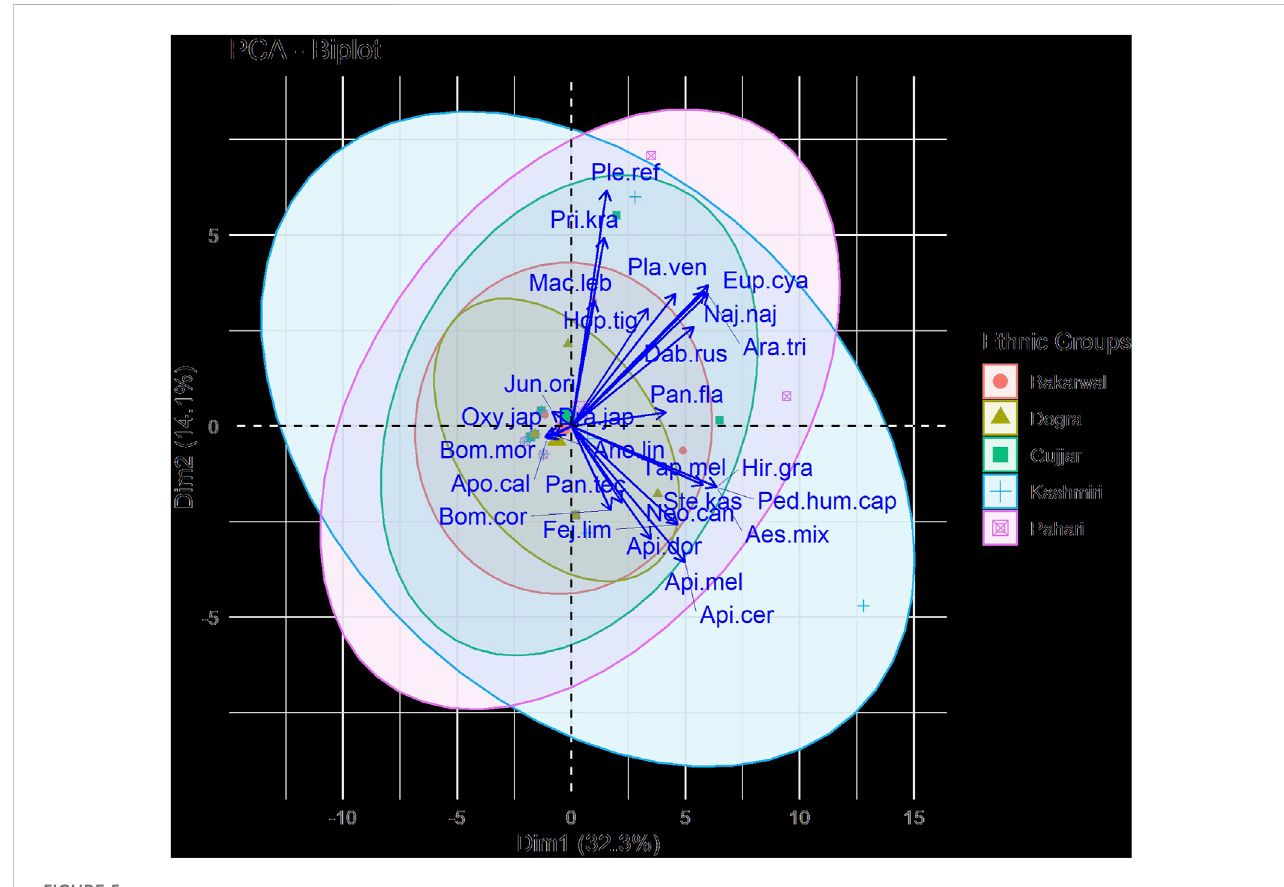
FIGURE 5 PCA diagram representing clustering of species among ethical